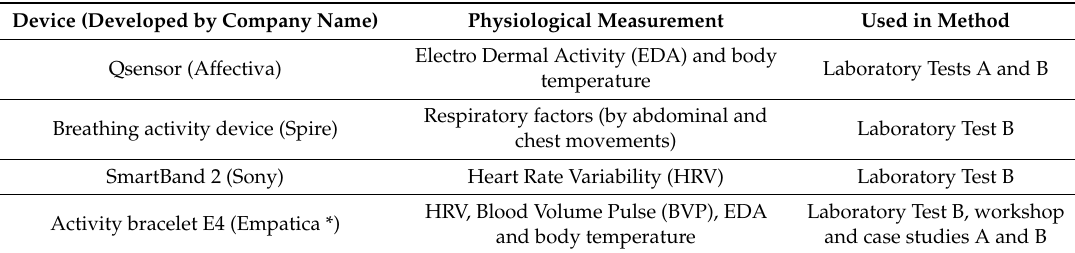
Table 2. Devices and physiological measurements used (connected to